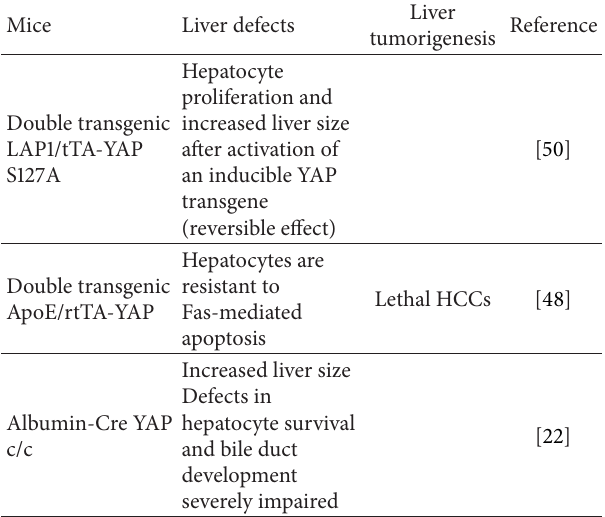
Table2:DescriptionofthedifferentphenotypesresultingfromYAP activation in